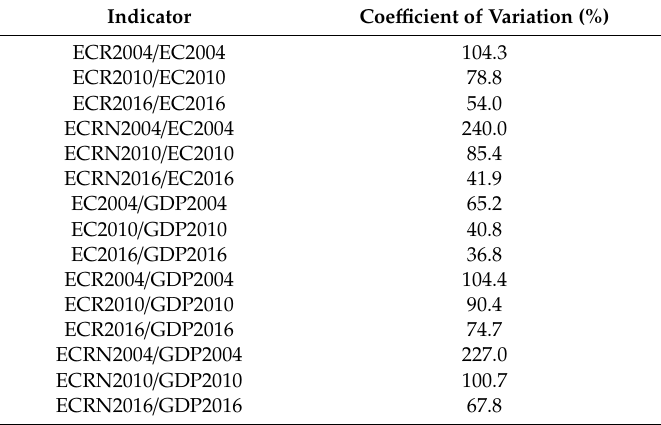
Table 3. Coe ffi cients of variation of the